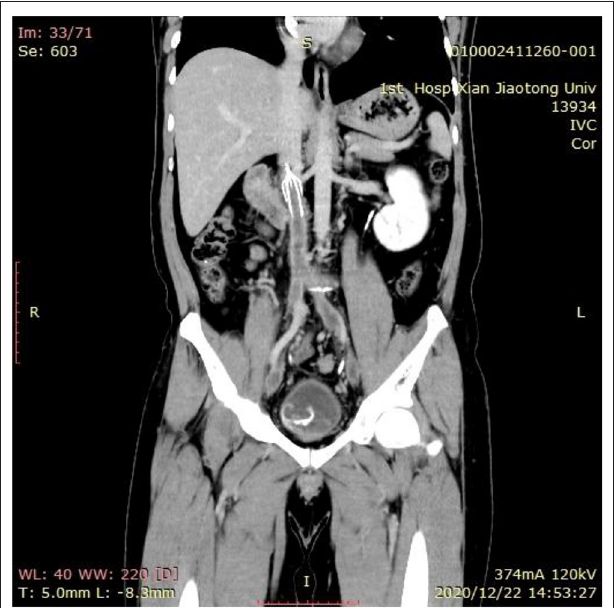
FIGURE 3 | The CT examination of the lower extremity veins showed implantation of the inferior vena cava filter, inferior vena cava and bilateral external iliac vein thrombosis, and bilateral internal iliac vein thrombosis.